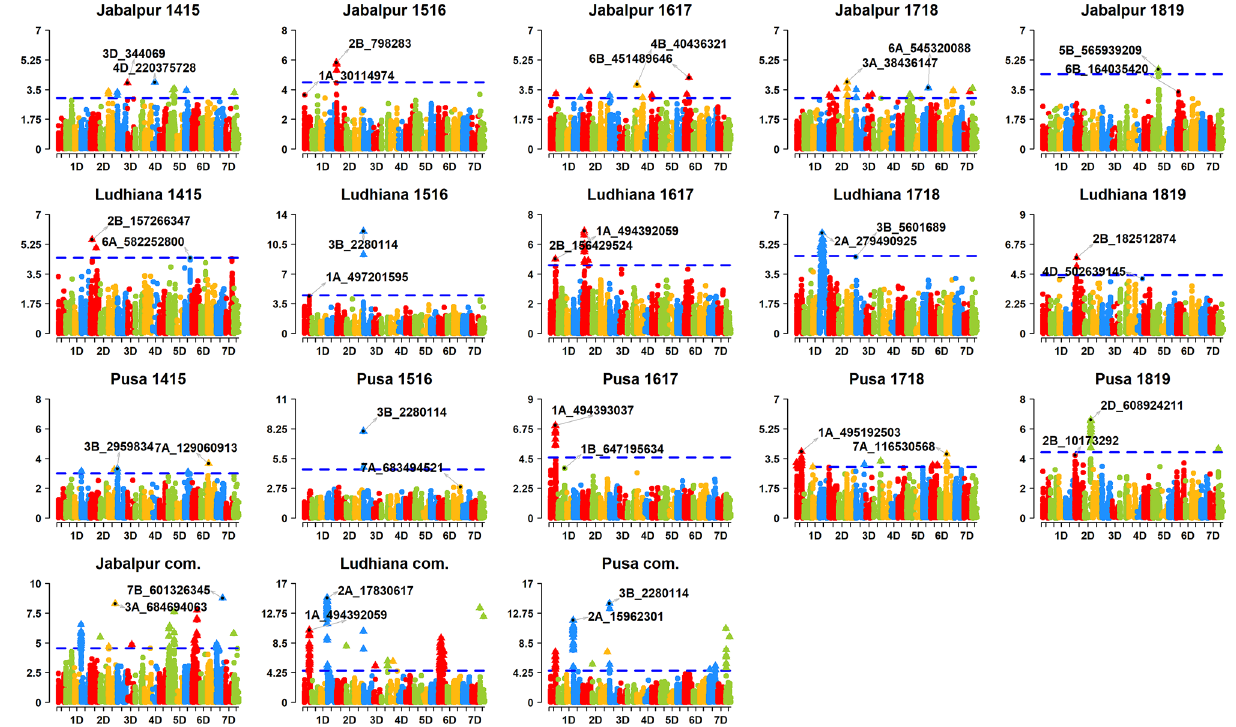
Figure 5. Markers significantly associated with grain yield evaluated in the irrigated-flat planting environments of Jabalpur, Ludhiana and Pusa (India), during the 2014–2015 (1415), 2015–2016 (1516), 2016–2017 (1617), 2017–2018 (1718) and 2018–2019 (1819) crop cycles and in the combined (com.) analysis across crop cycles. The chromosomes are shown in the x-axis and the − log 10 p values in the y-axis. The threshold lines correspond to the threshold using the Bonferroni correction for multiple testing at an α level of